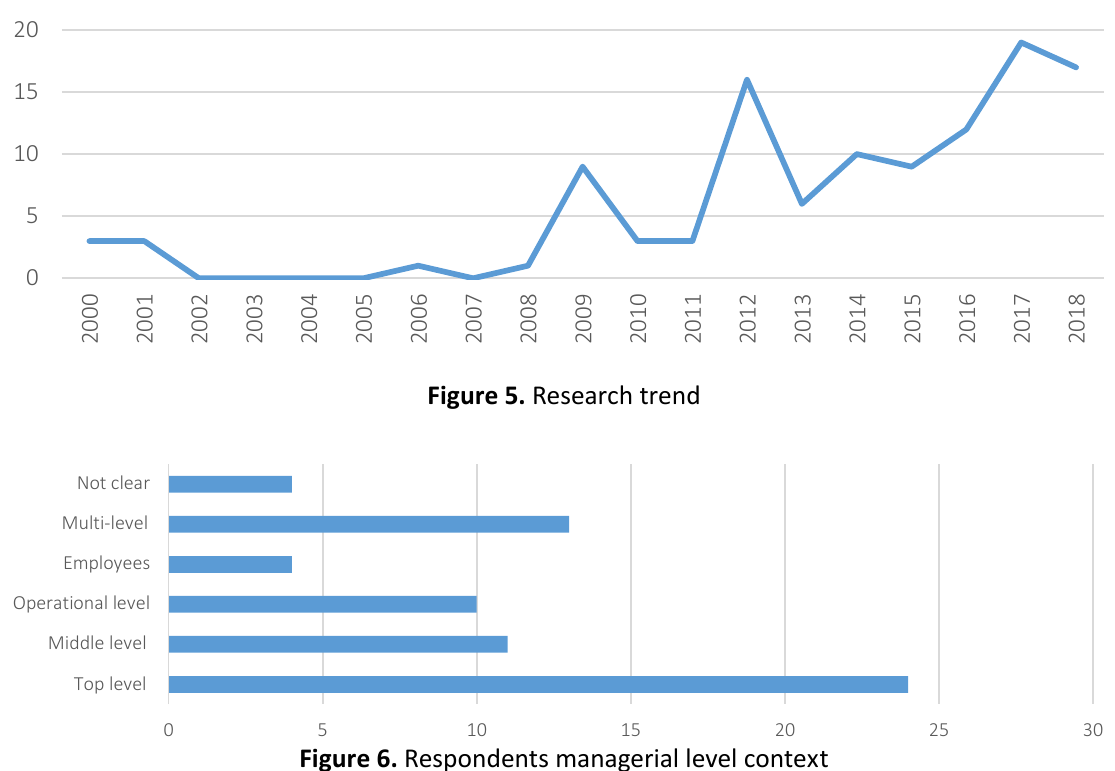
Figure 6. Respondents managerial level